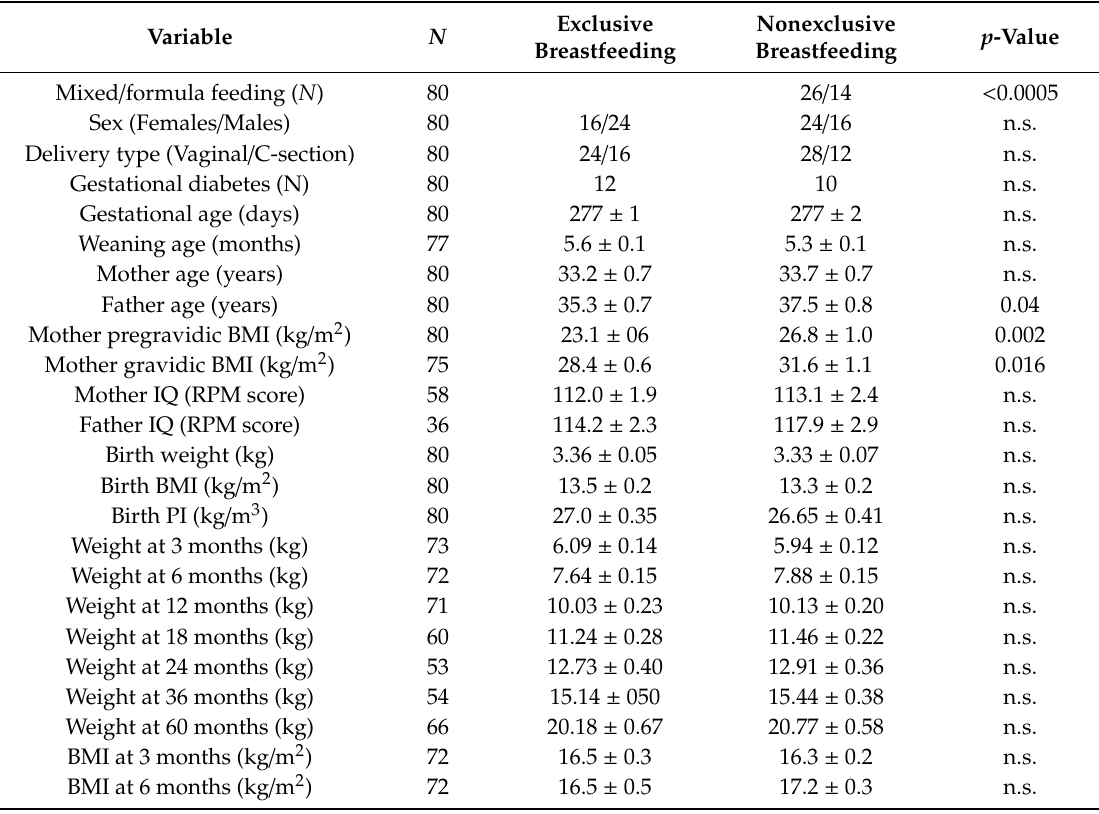
Table 1. Characteristics of exclusively and nonexclusively breastfed